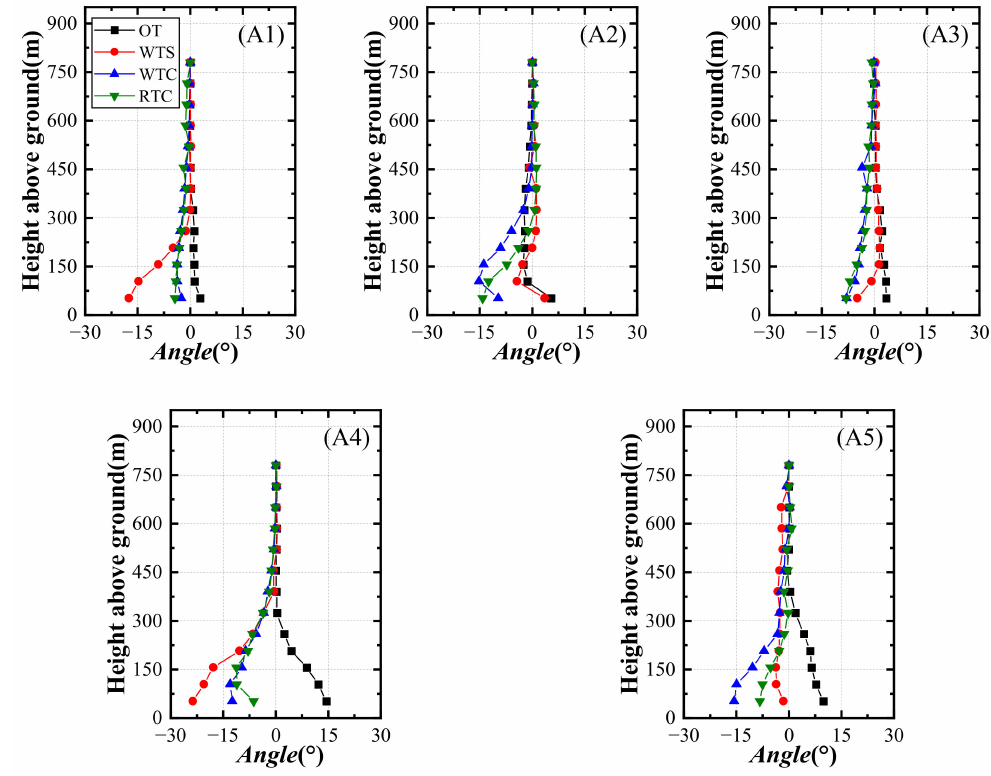
Figure 6. Profiles of inclination angle at measurement locations: (A1) location A1; (A2) location A2; (A3) location A3; (A4) location A4; (A5) location